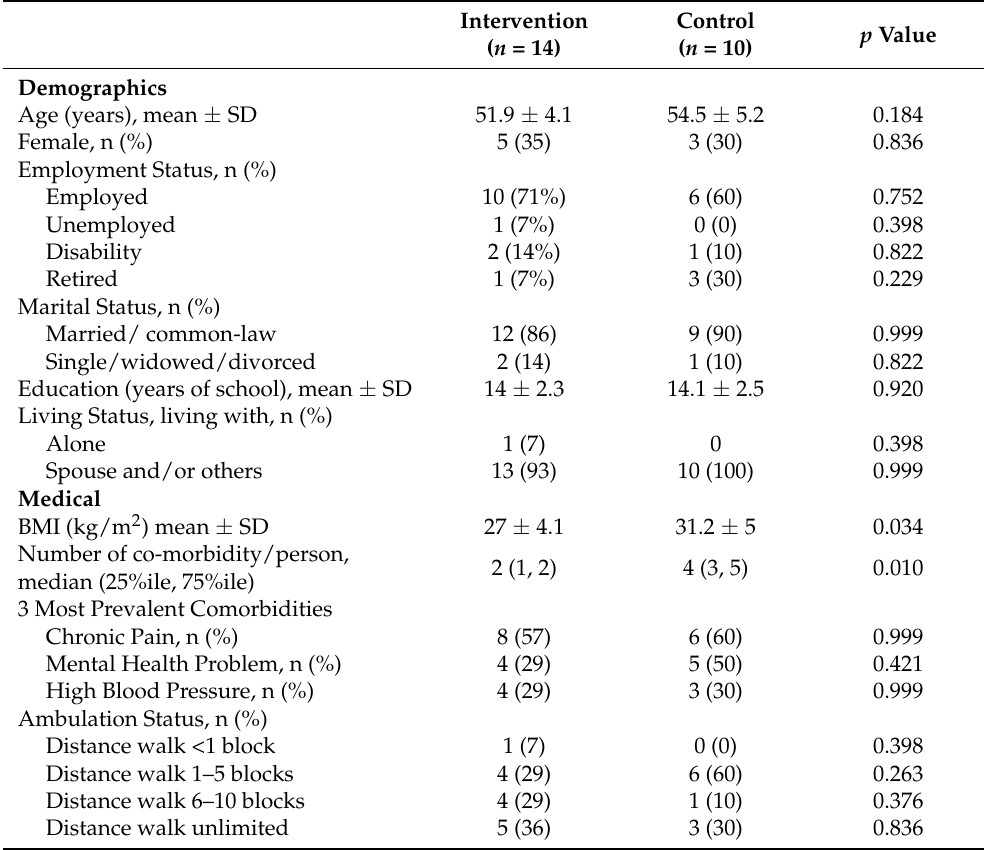
Table 1. Baseline characteristics of